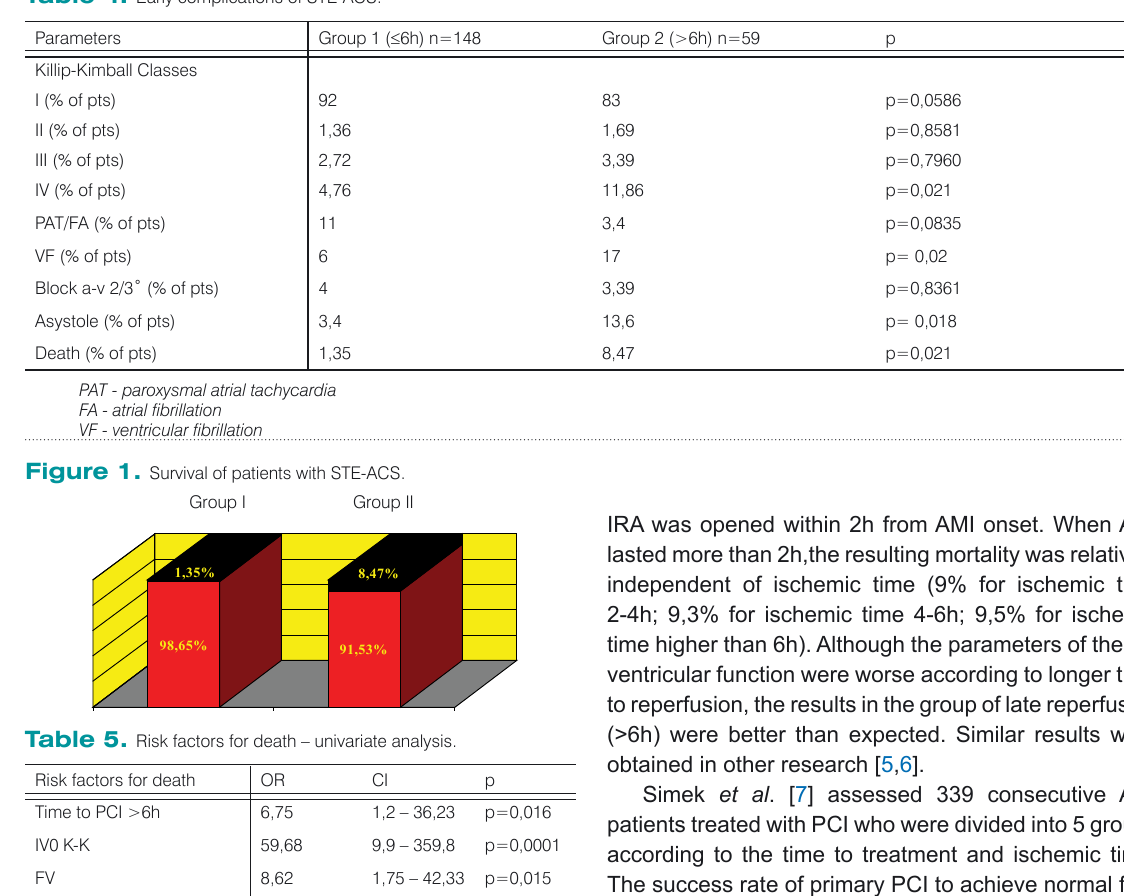
Table 4. Early complications of STE-ACS.